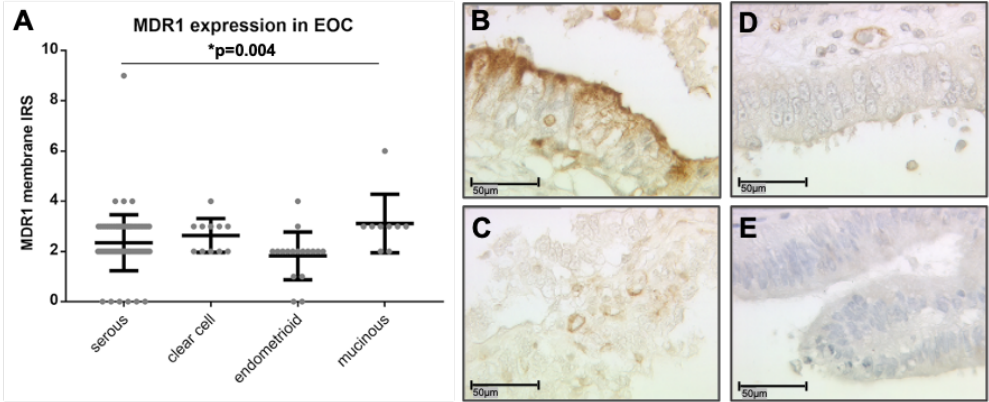
Figure 1. MDR1 immunostaining of ovarian cancer cells. Membranous expression of MDR1 on ovarian cancer cells differs between the subtypes ( A , p = 0.004) with mucinous ( B , IRS = 6) and clear cell ( C , IRS = 4) showing a higher expression than serous ( D , IRS = 3) and endometrioid ( E , IRS = 2). ( B – E ) are shown in 40 × magnification (scale bar = 50 µm), 25 × magnification is provided in the Supplementary Figure